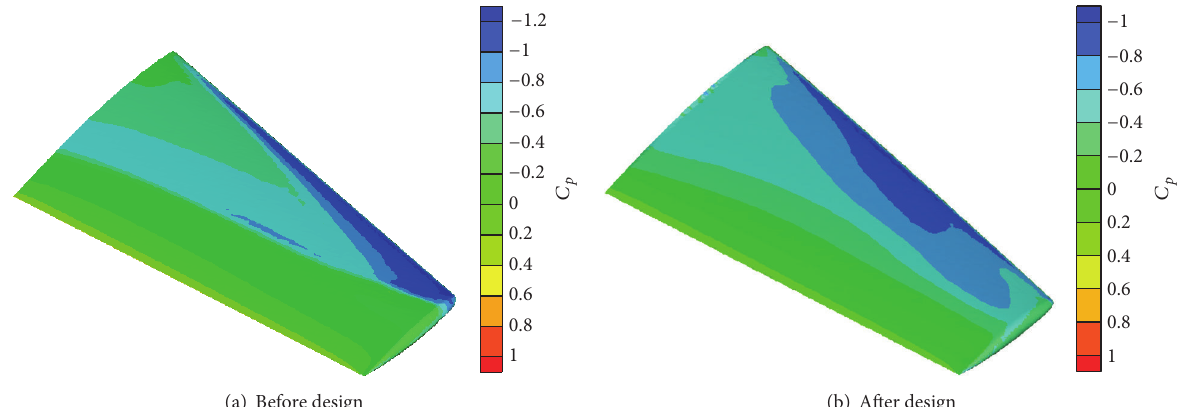
Figure 6: Contours of pressure coefficient of ONERA M6.